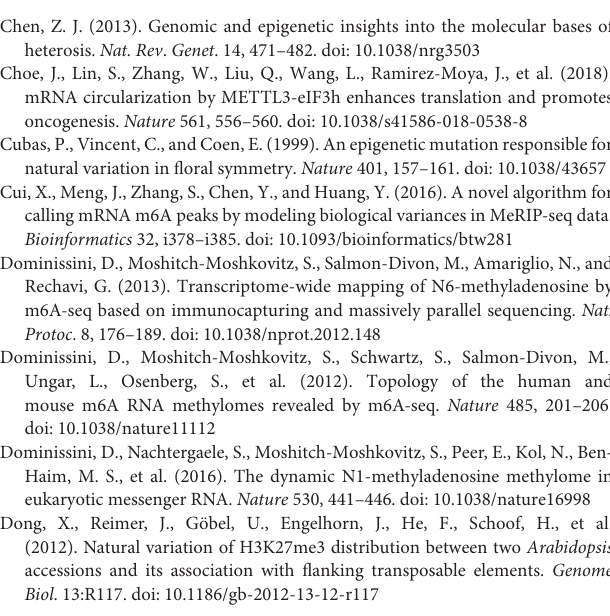
Supplementary Table 2 | List of DMPs between the samples. Supplementary Table 3 | List of non-additive and additive expressed genes and m 6 A peaks in hybrids. Supplementary Table 4 | The results of GO analysis of DMPs in each comparison. Supplementary Table 5 | Shared GO terms of any two samples. Supplementary Table 6 | Genes related to growth